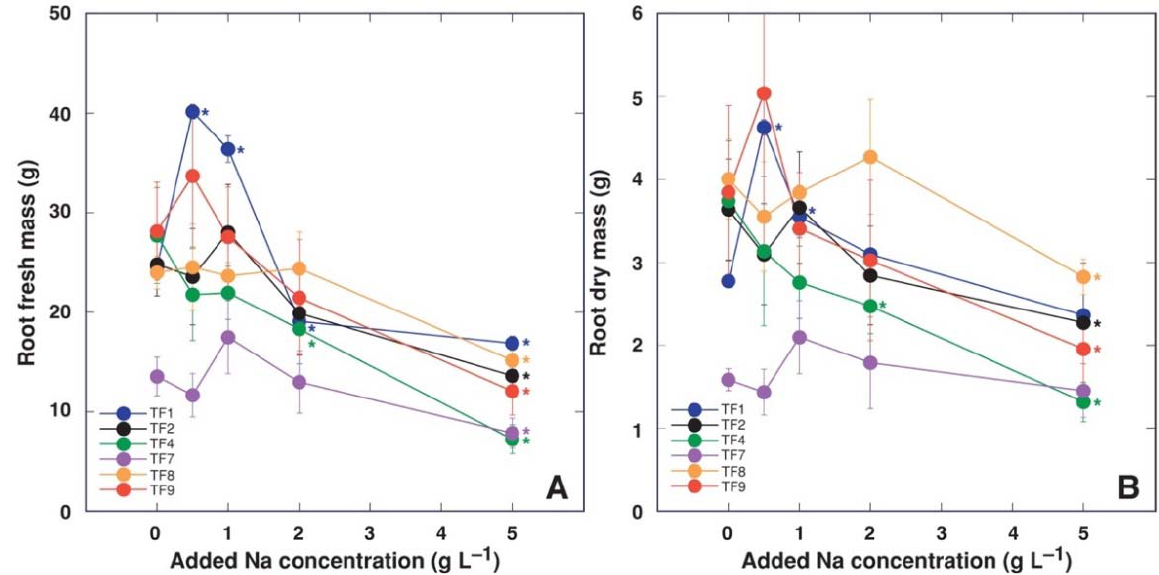
Figure 2. Effect of increasing substrate salinity on root fresh mass ( A ) and root dry mass ( B ) of Trifolium fragiferum plants of different accessions. Asterisks of respective color indicate statistically significant differences from control ( p < 0.05).